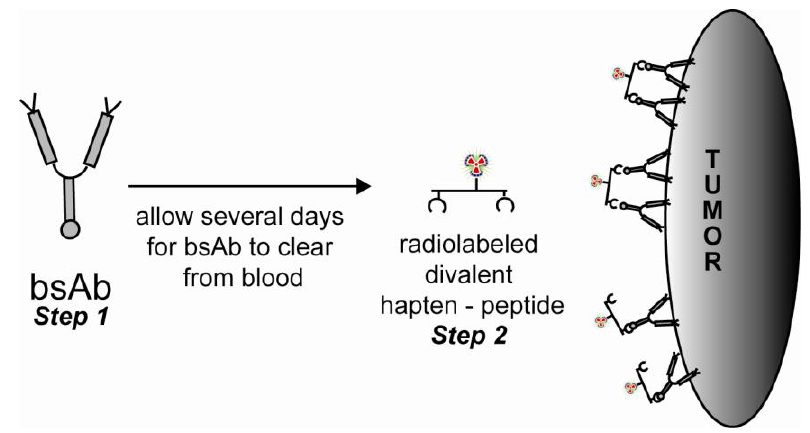
FIGURE 2. In pretargeting by the bsAb approach, a bsAb is first injected. After tumor targeting and clearance of the bsAb from circulation, a peptide with two hapten moieties and a therapeutic or a diagnostic radionuclide is administered. One bivalent hapten can cross-link two closely spaced bsAb molecules on the tumor cell